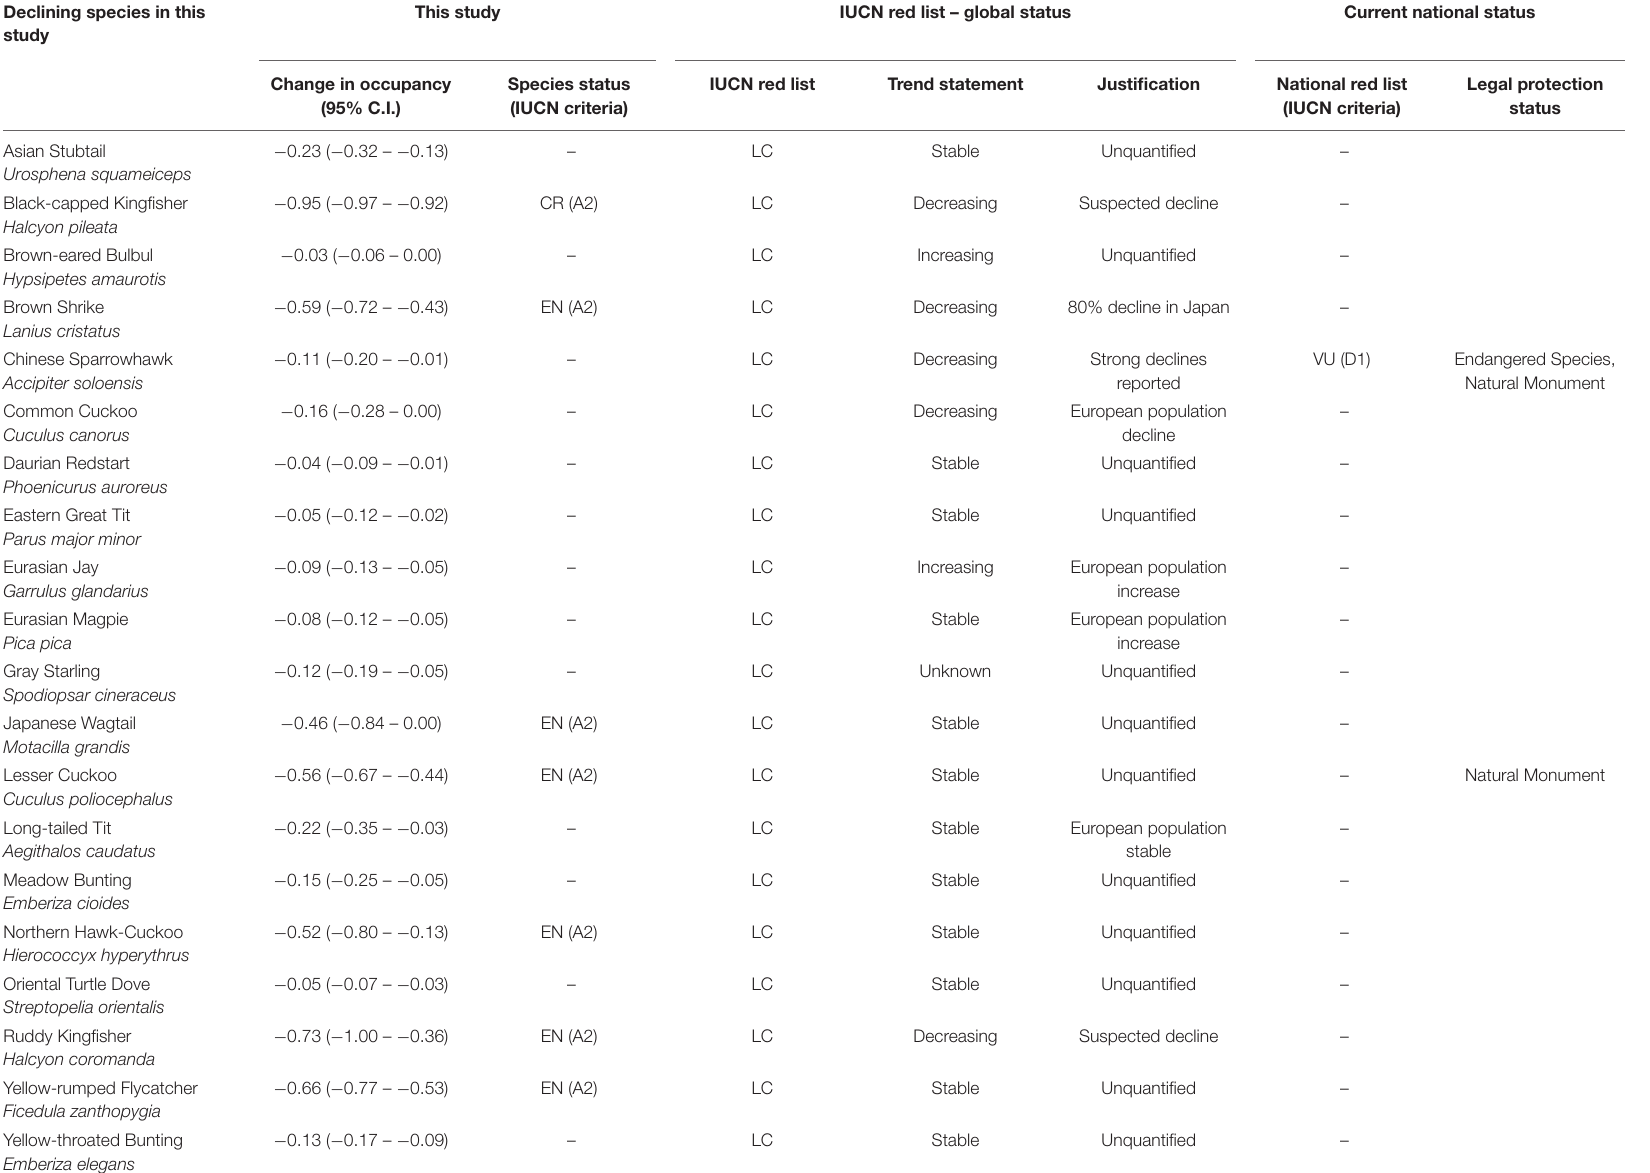
TABLE 1 | Comparison of current species status assessments and re-evaluation of national level species status for declining species in this study. Declining species in this